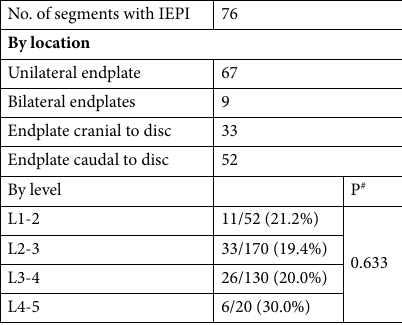
Table 2. The numbers of segments with intraoperative endplate injury (IEPI) according to the location and disc level. # Linear-by-linear association test was